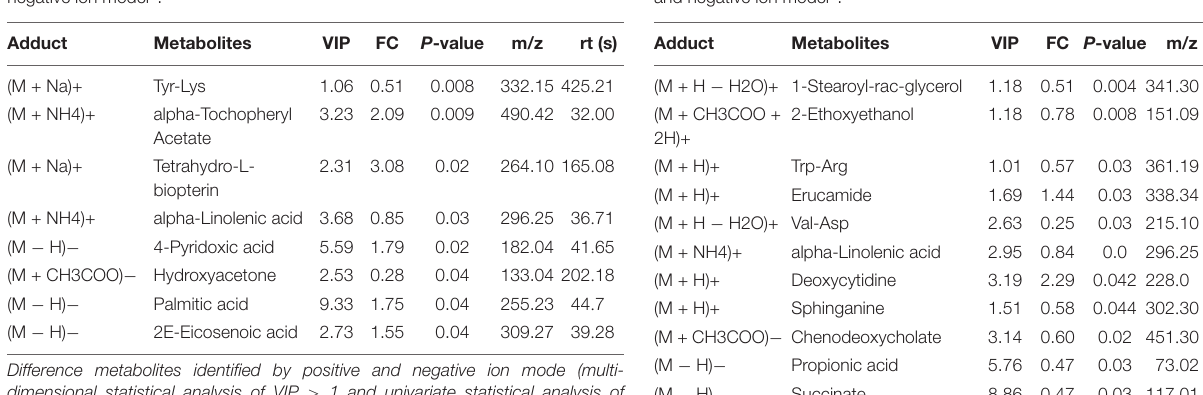
TABLE 2 | Identified significantly different metabolites from Enterotoxigenic Escherichia coli (ETEC) and ETEC + Sodium humate (HNa) groups under positive and negative ion model a .